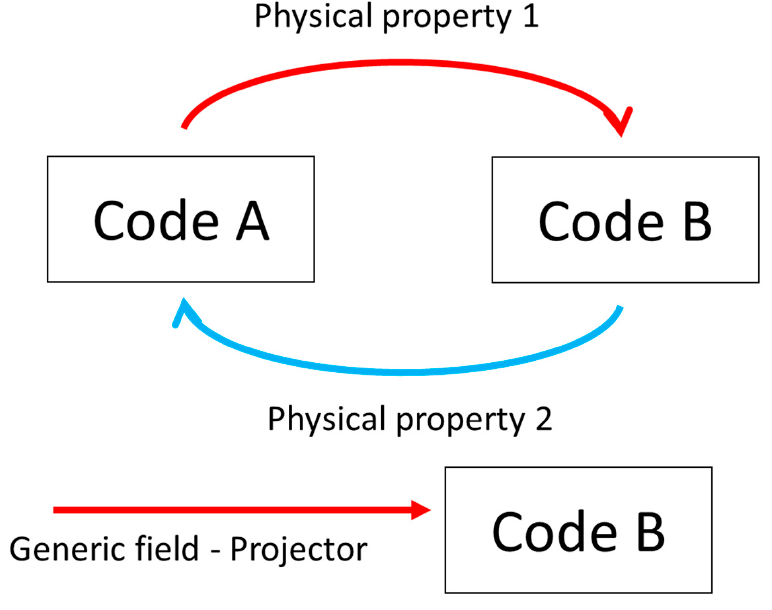
Figure 9. ATHENA coupling principle [16].